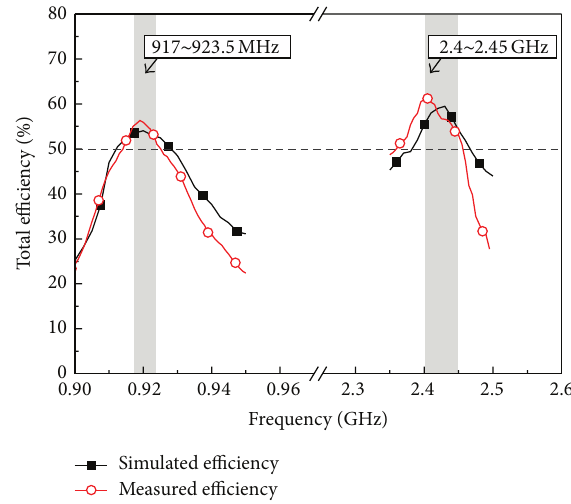
Figure 6: Total efficiency of the proposed antenna without metallic objects.